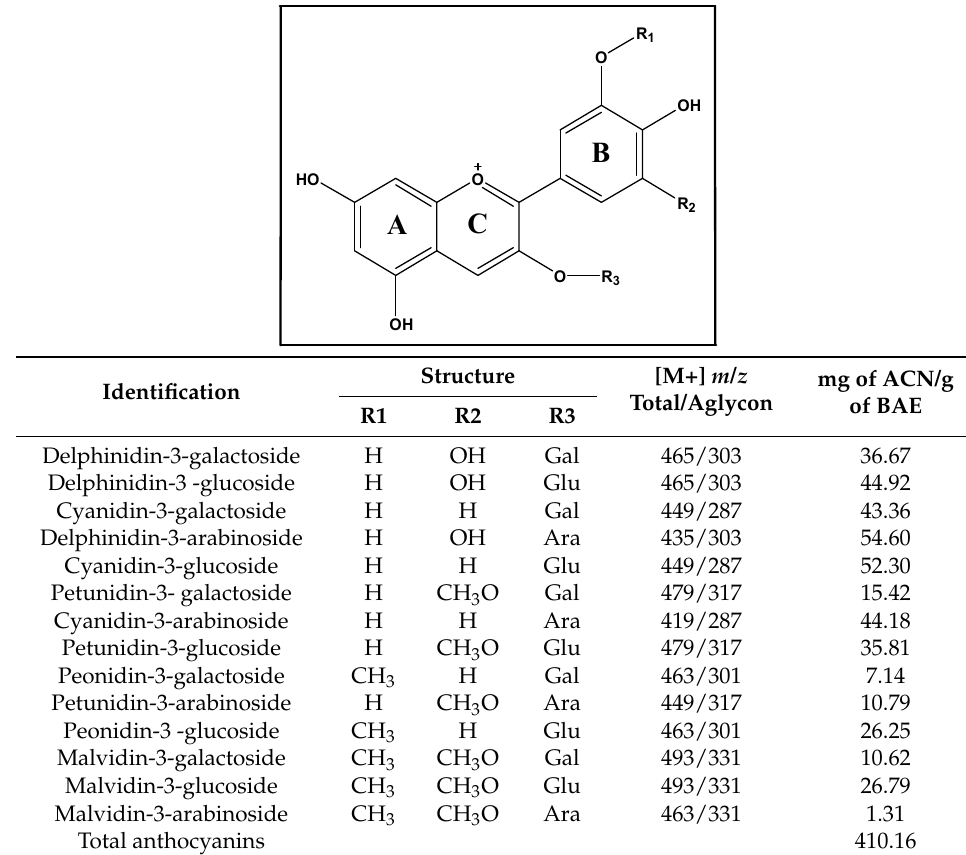
Table 1. Structure and concentrations of the individual anthocyanins in bilberry anthocyanin extract.